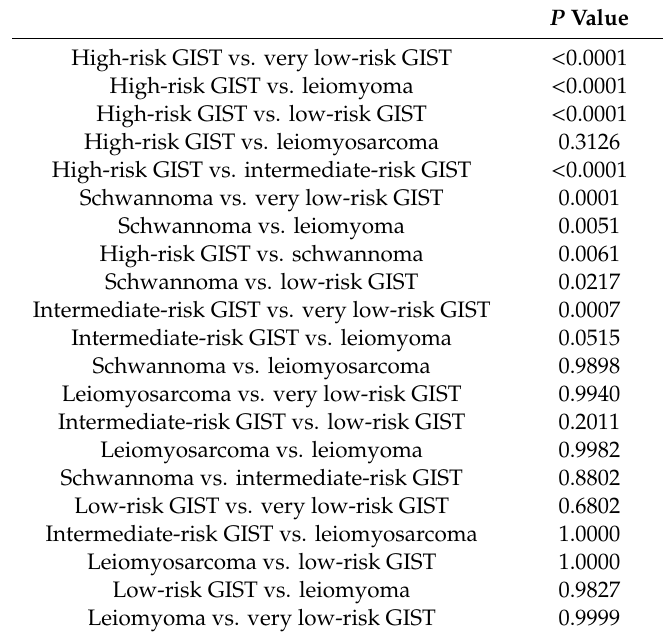
Figure 2. Box-and-whisker plots of the SUVmax of gastric mesenchymal tumors. * P < 0.05; † P < 0.01; ‡ P < 0.001. Table 2. Results of one-way analysis of variance followed by Tukey–Kramer post hoc test with respect to the SUVmax across pathological